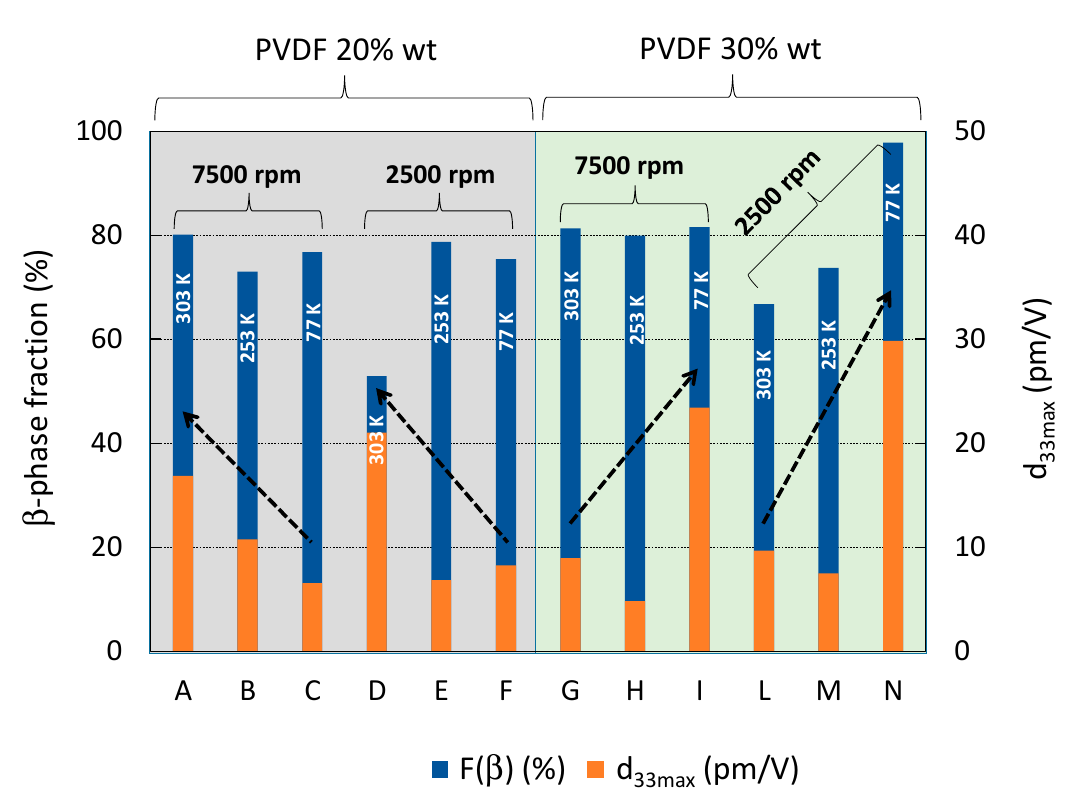
Figure 9. β -phase relative volume fraction and maximum measured piezoresponse coe ffi cient of all produced